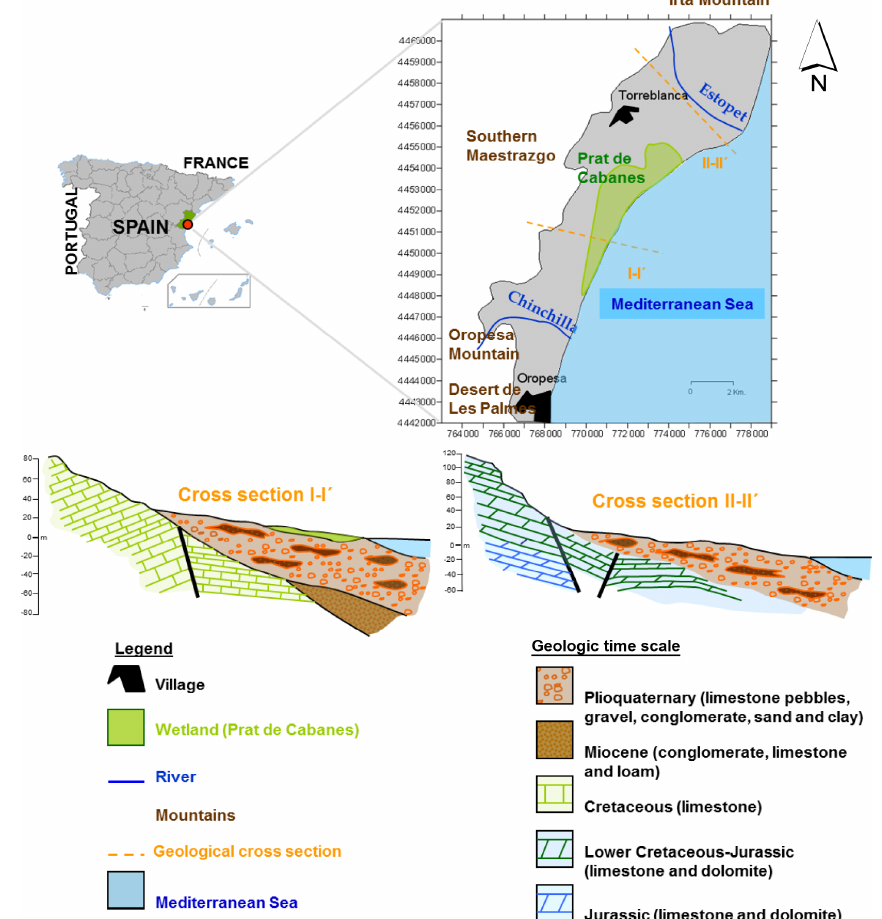
Figure 1. Location map area and cross sections of the